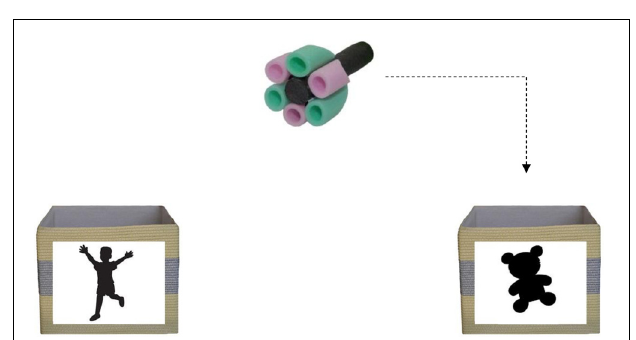
FIGURE 1 | Novel targets.